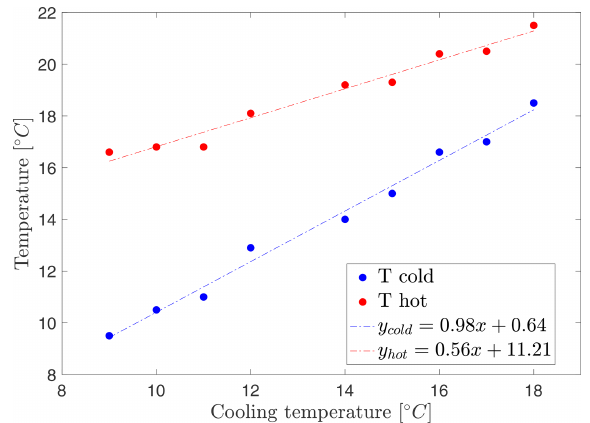
Figure 2. Temperature in the cold inner cylinder (blue) and hot outer ring (red) as a function of the cold thermostat target value. In the experiments discussed here (see Table 1), the temperature of the cooled water was increased 1.75 times more than the tempera- ture of the heated water. The series of experiments form an Arctic amplification scenario with an increase in mean temperature but a decrease in the radial temperature gradient. Table 1. Overview of the experimental runs. T C is the temperature of the cooling thermostat. T cold and T warm are the measured tem- peratures in the inner and outer ring, respectively. T = (T warm + T cold )/ 2 is the mean temperature. (cid:49)T = T warm − T cold is the ra- dial temperature difference. m is the azimuthal wavenumber of the baroclinic wave, and I indicates irregular waves. The rotation rate is (cid:127) = 8rpm for all runs. Ro T is the thermal Rossby number (Eq. 2). The Taylor number (Eq. 1) is Ta = 1 . 32 × 10 8 . All temperatures in the table are given in degrees